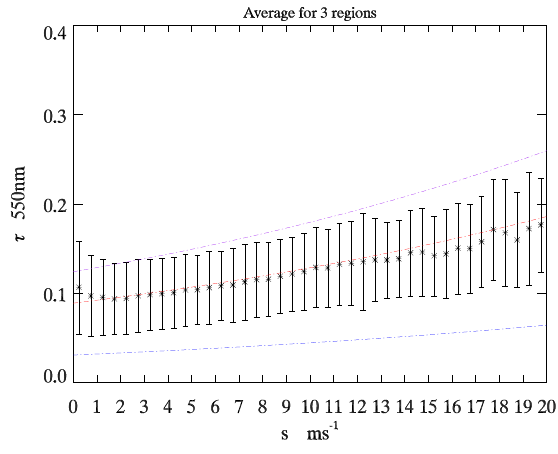
Fig. 10. The relationship between wind speed s and AOD τ at RH 80 %, the black crosses are the averaged result for three regions as shown in Fig.9, the three dash lines are the OPAC modelled result using different values of N 0 of sea salt, purple: 30 cm − 3 , close to the upper limit of sea salt number concentration; red: 20 cm − 3 , the default value of sea salt number concentration given OPAC; blue: 3 . 5 cm − 3 , closed to the lower limit of sea salt number concentra- tion.